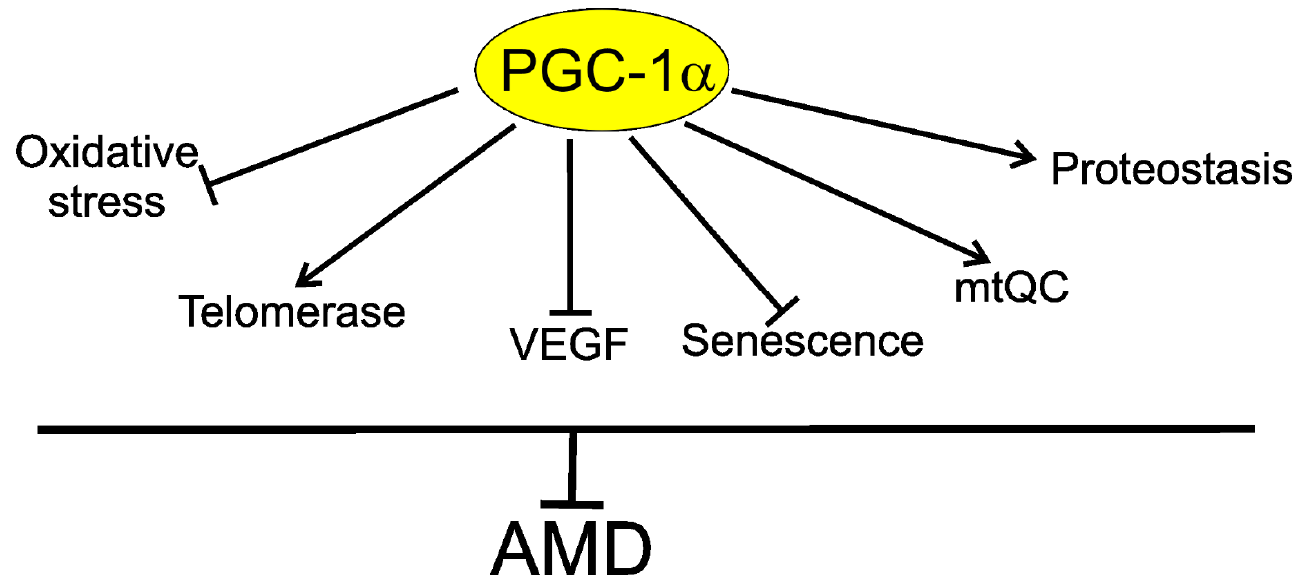
Figure 6. Telomerase is a component of the protective action of peroxisome proliferator-activated receptor gamma coactivator 1 alpha (PGC-1 α ) against age-related macular degeneration (AMD). PGC-1 α may directly or indirectly influence several proteins, mechanisms, and pathways important in AMD pathogenesis, including decreasing oxidative stress, senescence, and vascular endothelial growth factor (VEGF); ameliorating mitochondrial quality control (mtQC) and proteostasis, including autophagy; and stimulating telomerase, which can directly improve impaired telomeres in retinal cells or interact with proteins involved in their protection against factors of AMD pathogenesis.